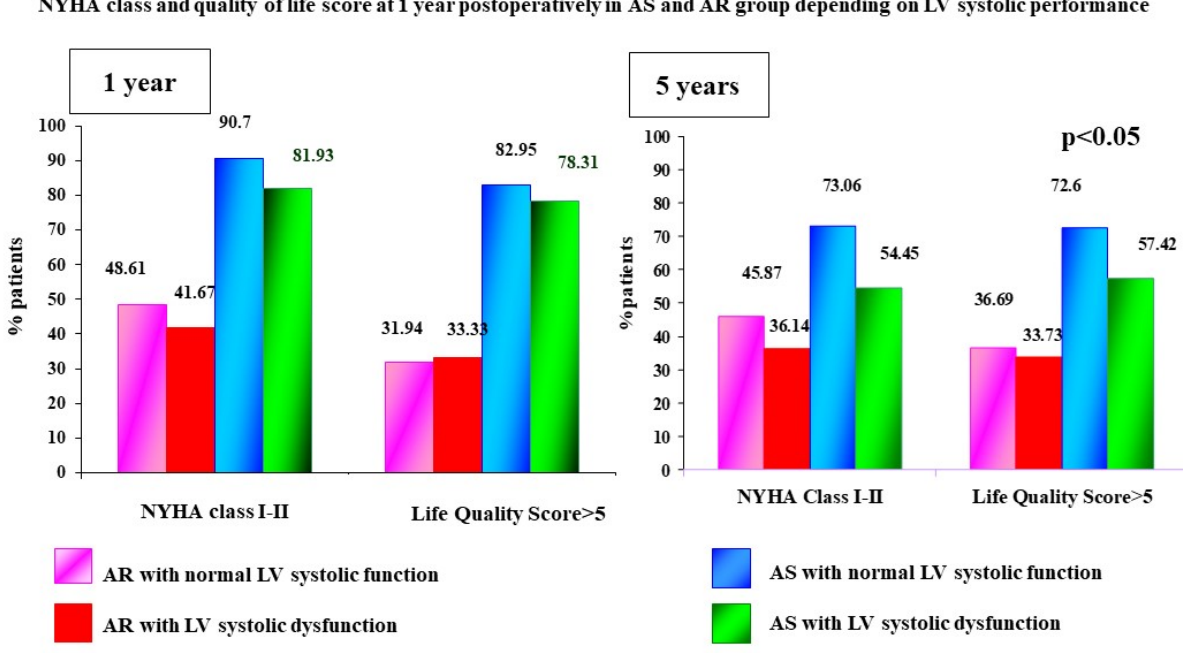
Figure 4. NYHA class and SR QOL > 5 at 1 year postoperatively in AS and AR group depending on LV systolic performance.